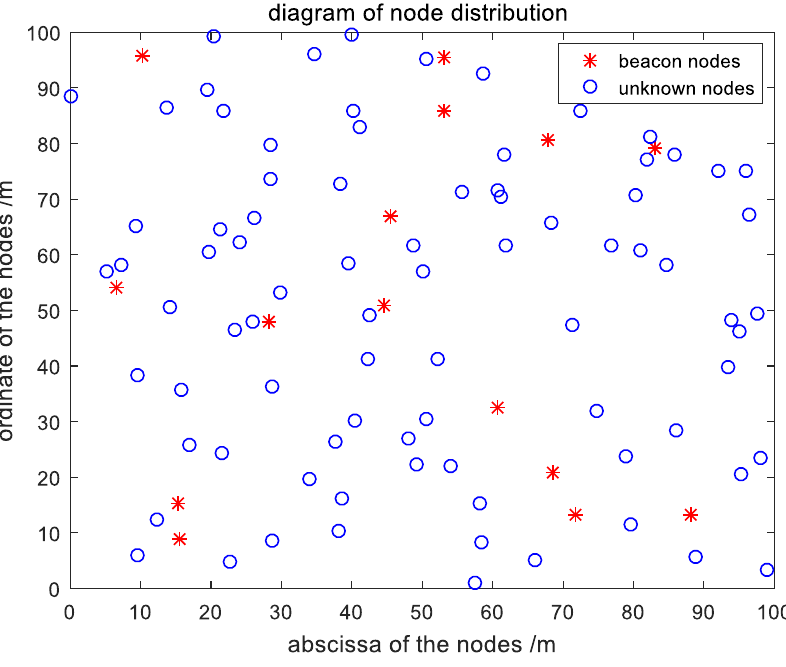
Figure 6. Diagram of random distribution of nodes.